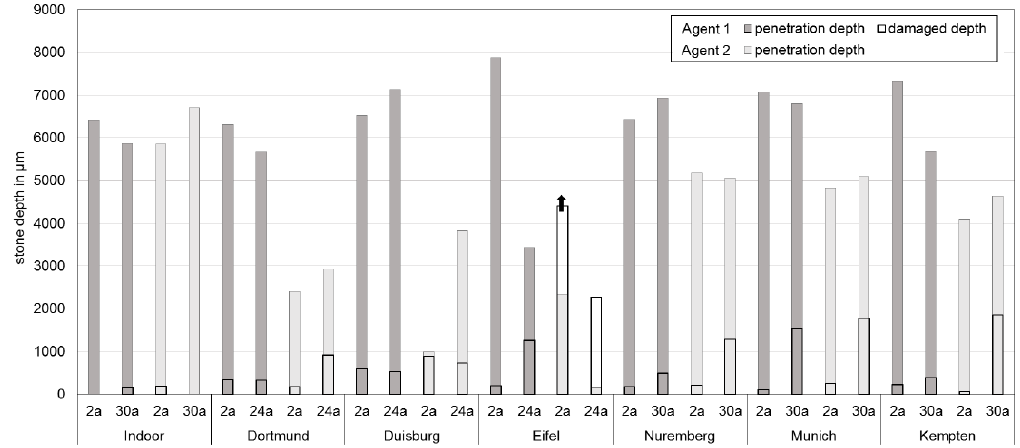
Figure 12. Comparison of the penetration depth of agents 1 or 2 applied on OKS with the damaged depth calculated with Equation (5) (depth 0 = surface of the stone).